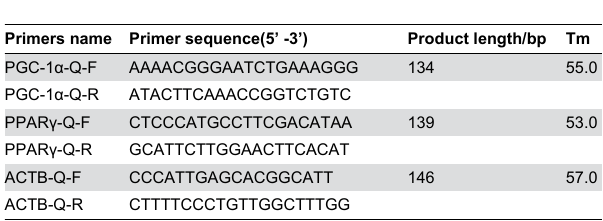
Table 3. Primer designed for gene expression